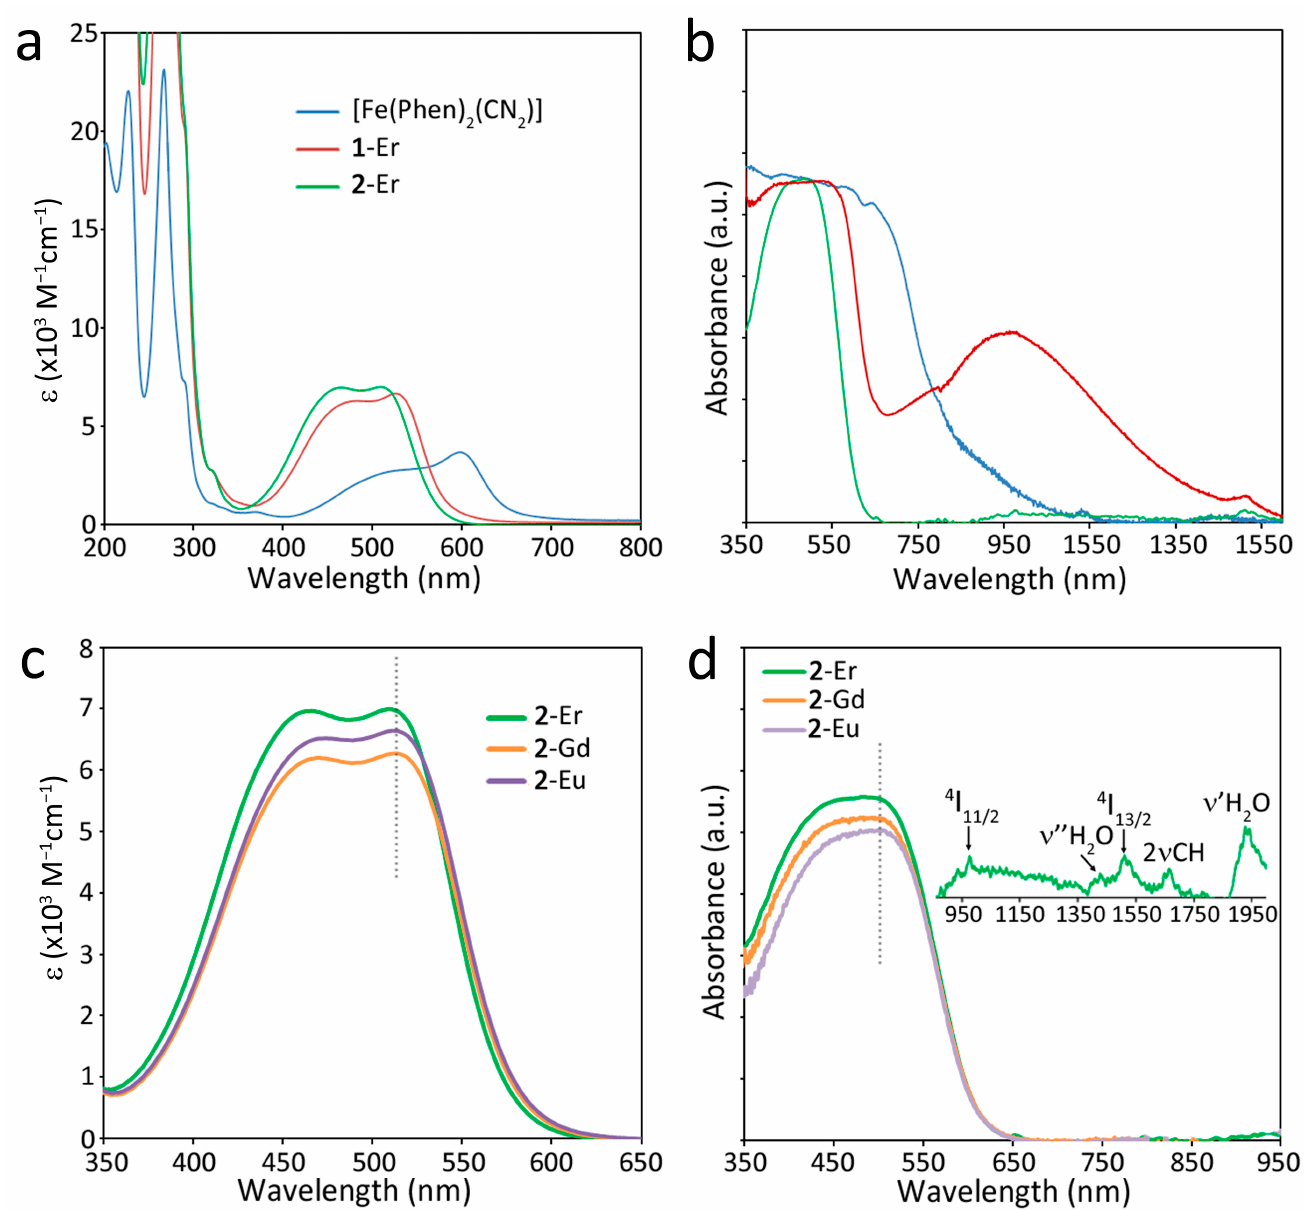
Figure 5. ( a ) Electronic absorption in acetonitrile solution and ( b ) diffuse reflectance spectra of crystalline samples of 1 -Er, 2 -Er and [Fe(Phen) 2 (CN) 2 ] in the UV-Vis-NIR range. ( c , d ) Enlargement of the lowest energy absorption bands of 2 -Eu, 2 -Gd and 2 -Er in acetonitrile solution and in the solid state, respectively. The inset in (d) reports the NIR spectrum of 2 -Er showing the significant spectral features related to Er(III) absorption and the vibrational overtones of water and CH groups.